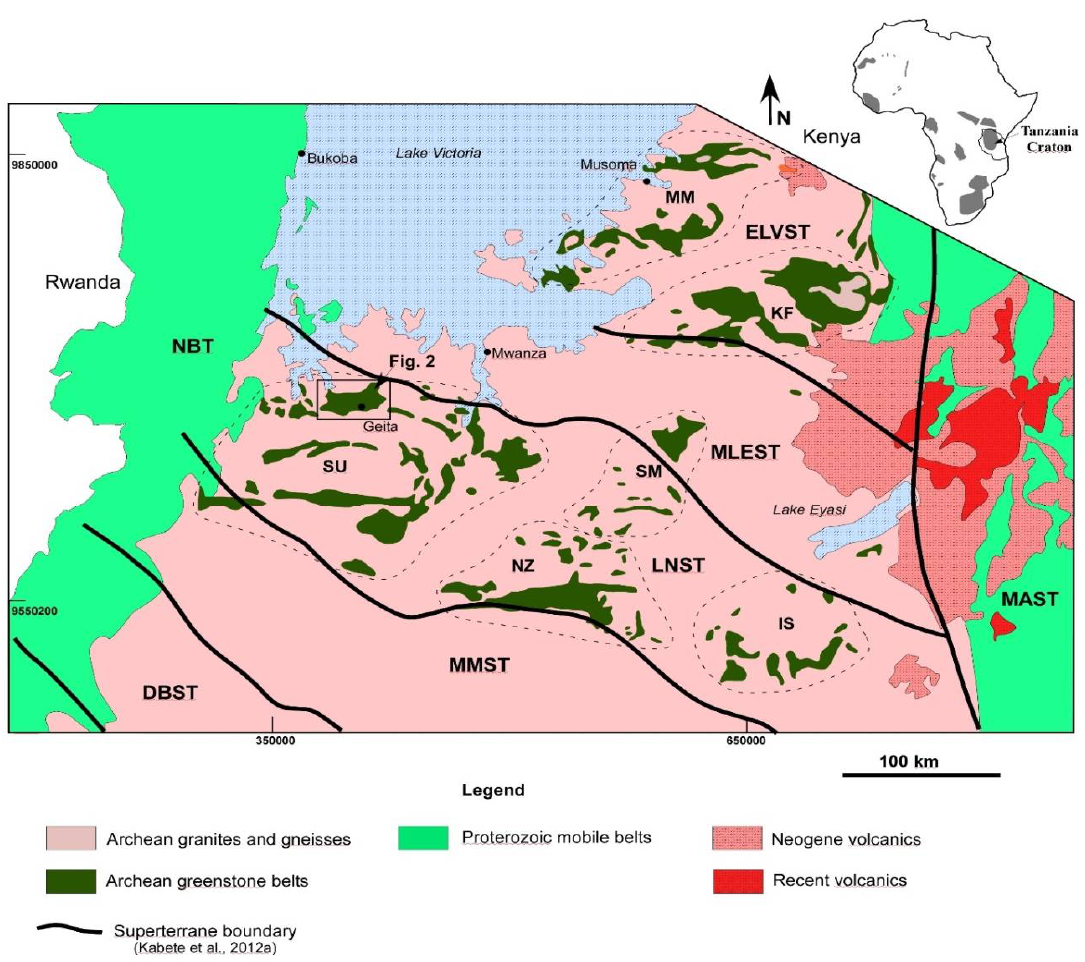
Figure 1. Geological map of the northern half of the Tanzania Craton, showing the main geological and tectonic units: IS—Iramba-Sekenke Greenstone Belt; KF—Kilimafedha Greenstone Belt; MM—Musoma-Mara Greenstone Belt; NZ—Nzega Greenstone Belt; SM—Shinyanga-Malita Greenstone Belt; SU—Sukumaland Greenstone Belt. Super-terrane boundaries are as proposed by [27]: DBST—Dodoma Basement; ELVST—East Lake Victoria; LNST—Lake Nyanza; MAST—Mbulu-Masai; MLEST—Mwanza Lake Eyasi; MMST—Moyowosi-Manyoni; NBT—Nyakahura-Burigi. The inset